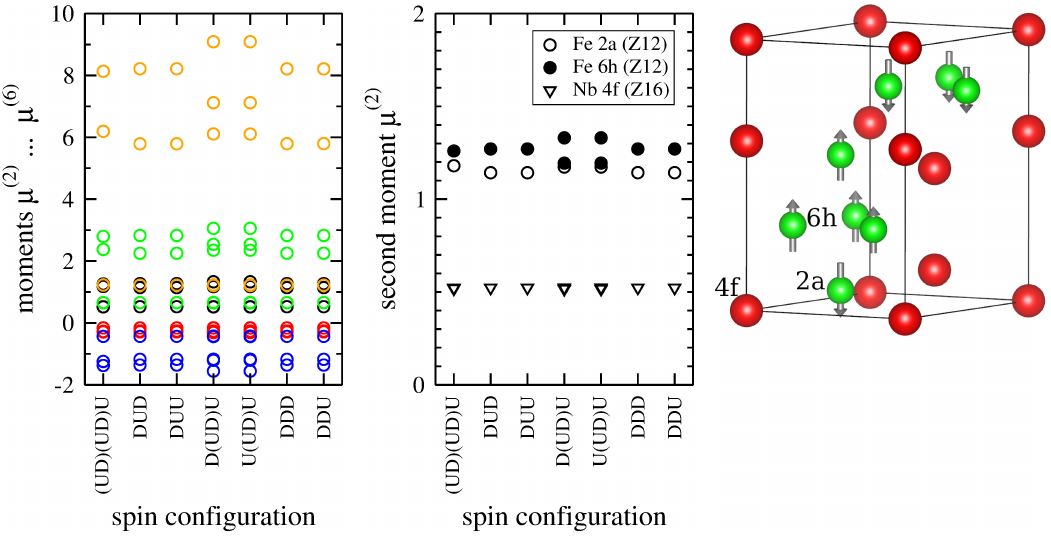
Figure 7. Variation of moments of C14-Fe 2 Nb ( left ) with spin configuration of the Wyckoff sites 2a, 6h and 4f ( right ), as well as site-resolved close-up on the second moment ( middle ). The ordering is according to structural stability [51] starting with the energetically most favorable configuration (UD)(UD)U that is also indicated in the crystal structure (right). (for color coding, see Figure